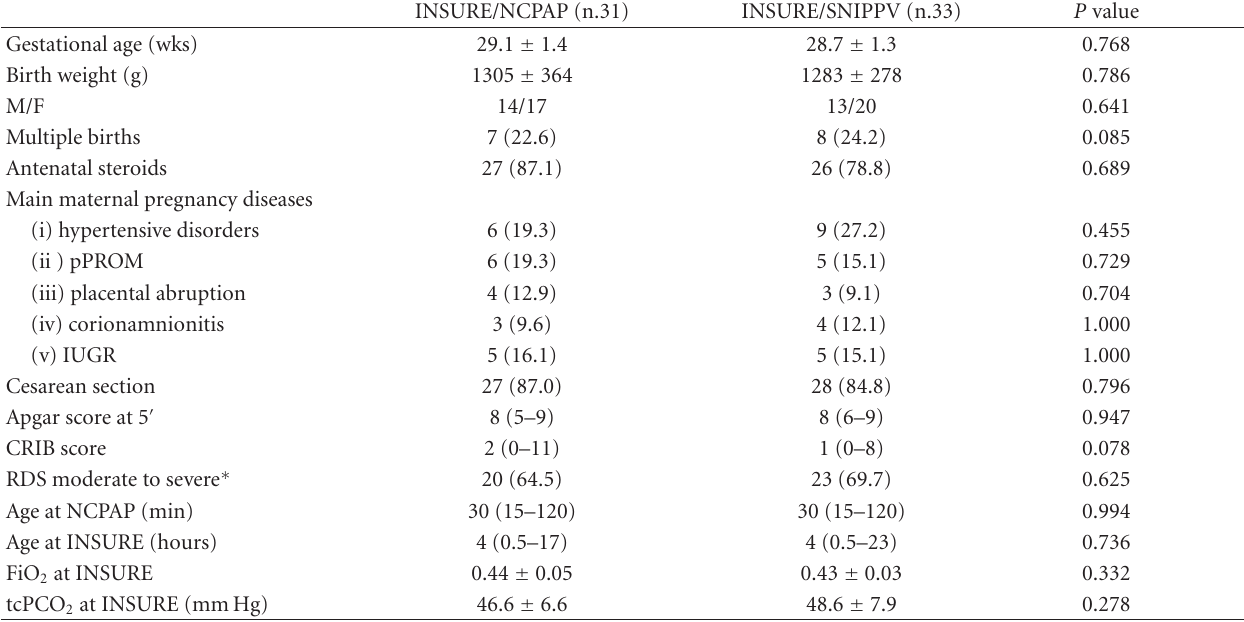
Table 1: Neonatal characteristic in the two study groups.